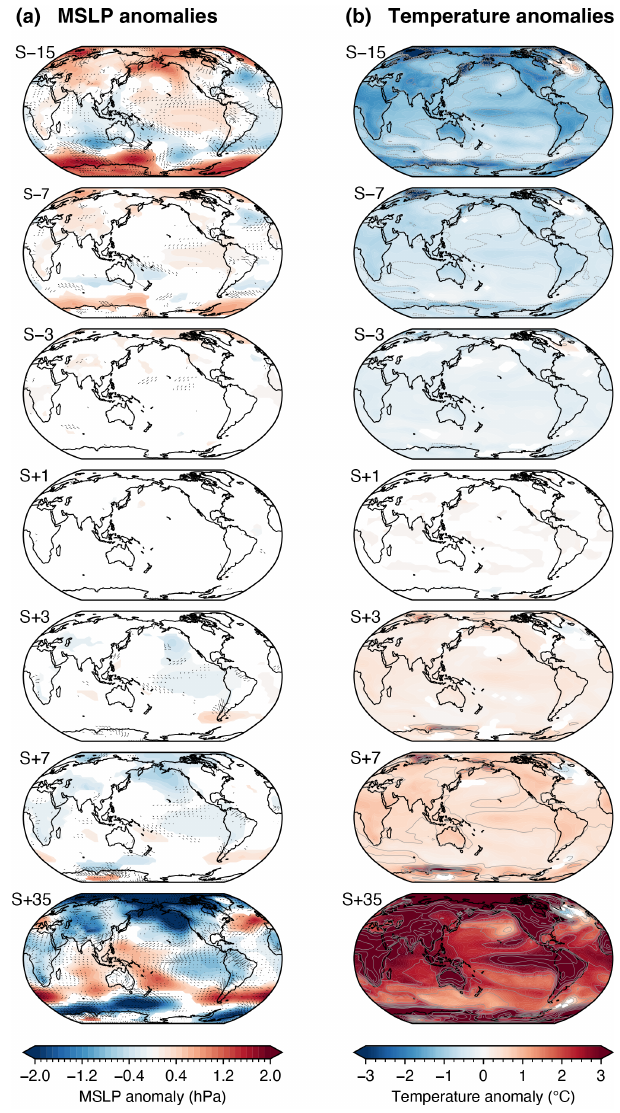
Figure 6. Surface anomalies (relative to the control run) for the first 200 years of the different solar constant experiments. (a) MSLP anomaly (shaded) and surface wind anomalies (vectors). (b) Surface temperature anomaly (shaded), with temperature contours addition- ally shown at 0.5 ◦ C increments (to assist in interpreting S + 35). Re- gions that are significantly different (based on a Welch’s t test, P < 0 . 05) are shown, while areas where P ≥ 0 . 05 have been masked